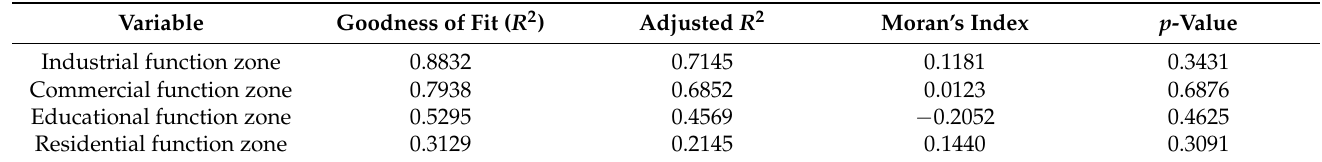
Table 9. Results of GWR model.